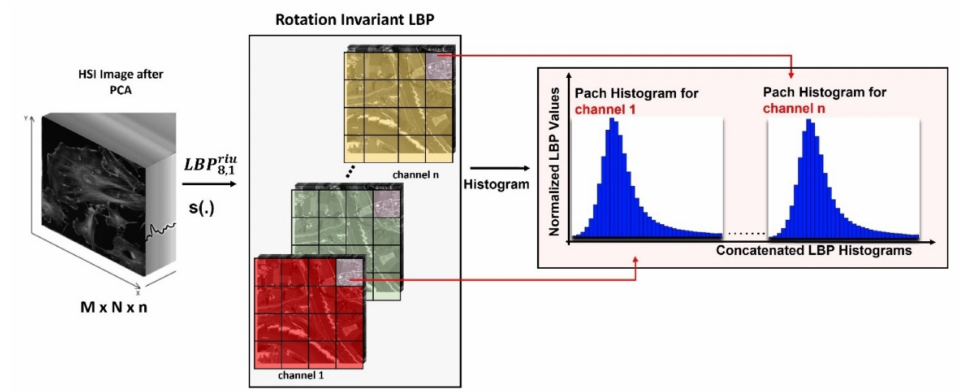
Figure 4. A representation of the final feature vector obtained based on the LBP patch histograms. The wavelet transform is applied along the spectral dimension of the HSI data